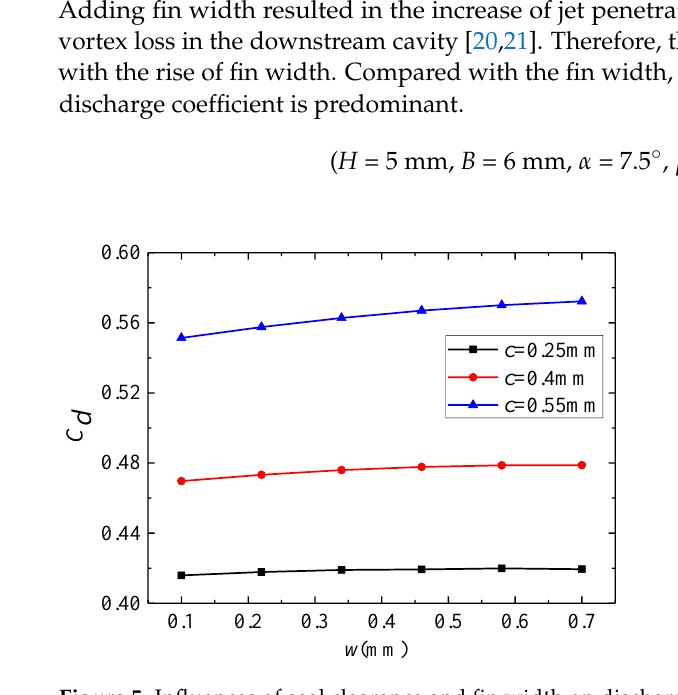
Figure 5. Influences of seal clearance and fin width on discharge coefficient. ( H = 5 mm, B = 6 mm, α = 7.5°, β = 7.5°)